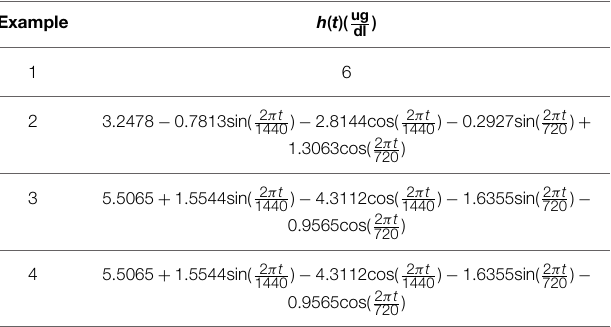
TABLE 3 | Lower bounds for examples of optimization problem (Equation 1).